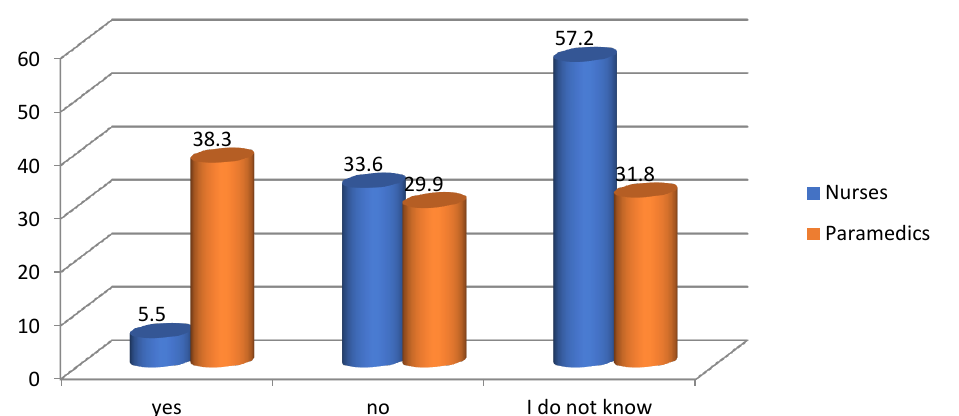
Figure 3. Results of self-assessment of the occurrence of occupational burnout among the respondents.